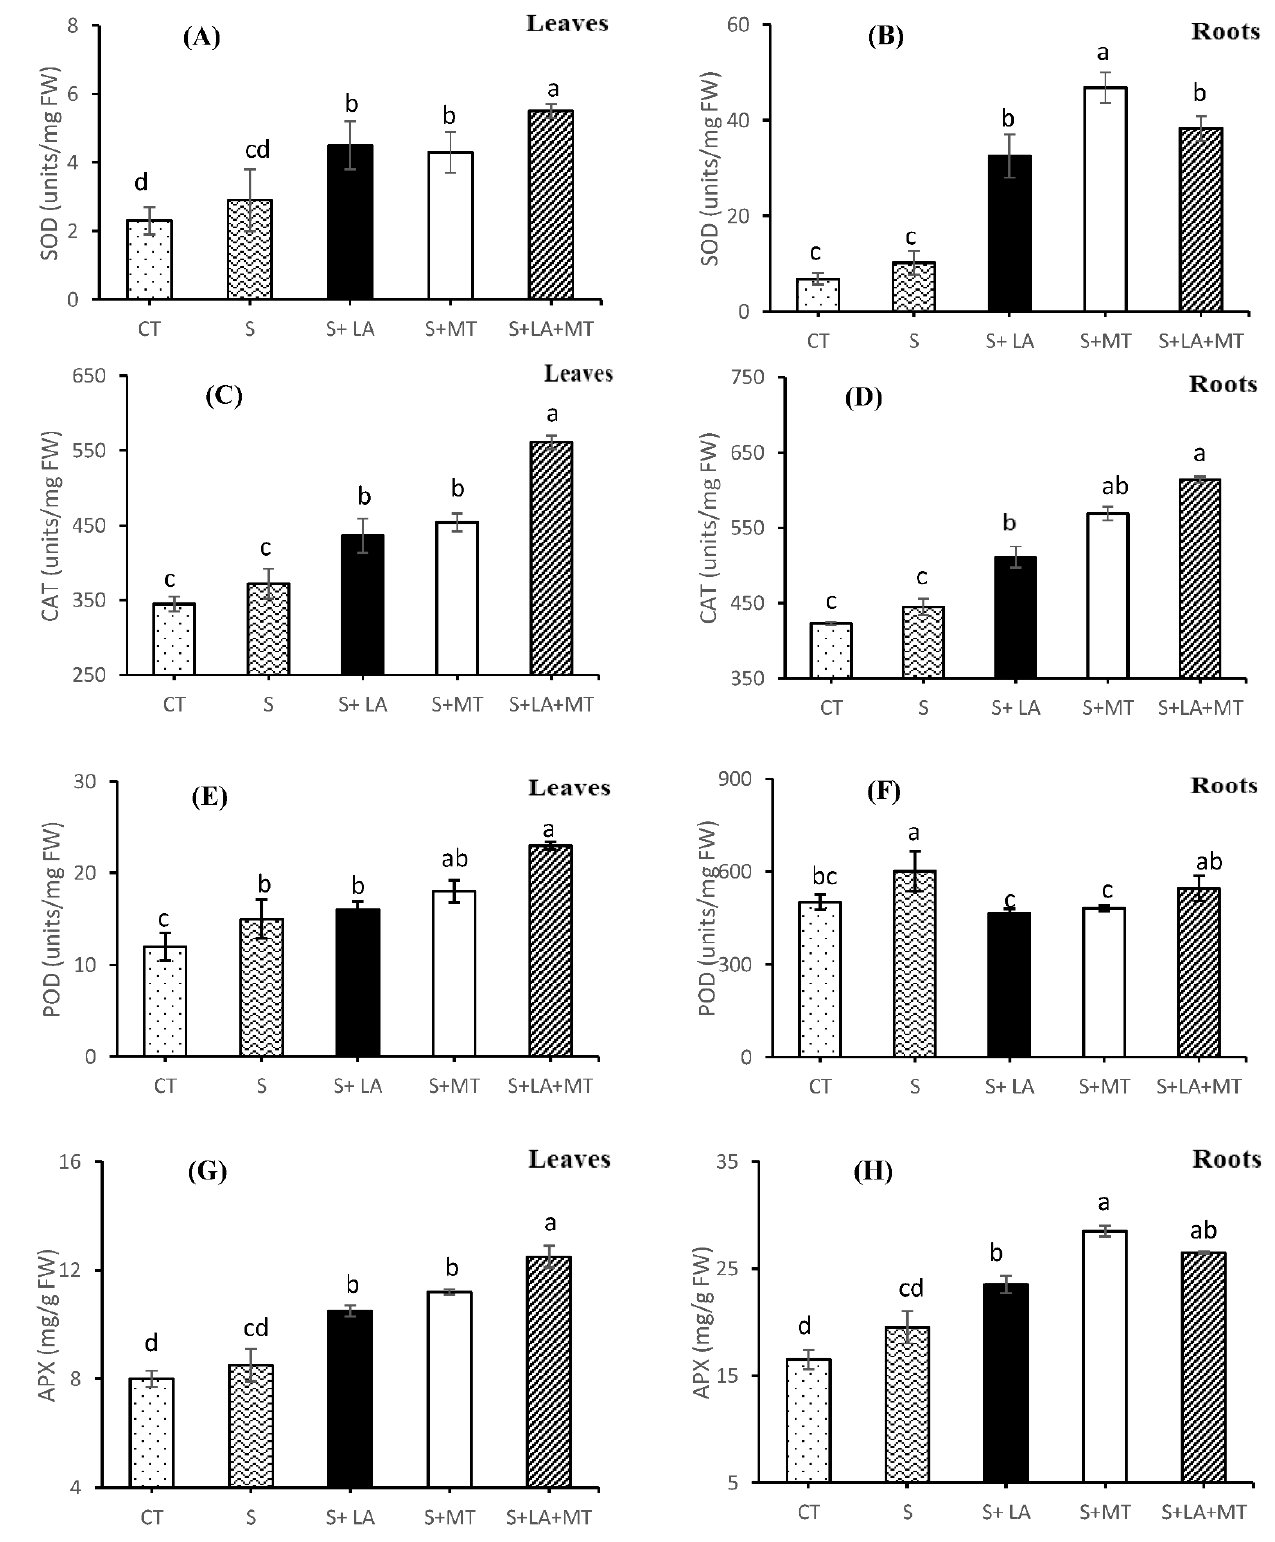
Figure 5. The effect of lipoic acid (LA), melatonin (MT) and their combination (LA + MT) under salt stress on SOD in leaves ( A ) and roots ( B ), CAT in leaves ( C ) and roots ( D ), POD in leaves ( E ) and roots ( F ) and APX in leaves ( G ) and roots ( H ) of Brassica napus L. seedlings exposed to salinity (100 mM NaCl) for 30 days. Abbreviations are given in Figure 1. Error bars on each column show the ± SE of three replication samples. Different letters on each bar indicate a significant difference according to LSD test ( p ≤ 0.05).